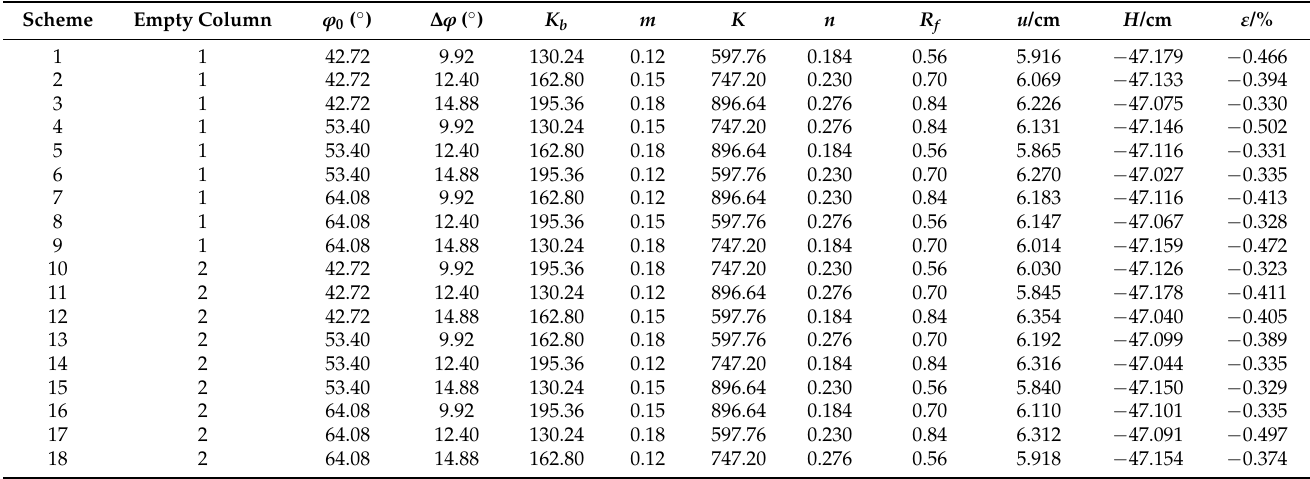
Table 7. Orthogonal test scheme and calculation results of reservoir bottom backfill zone.